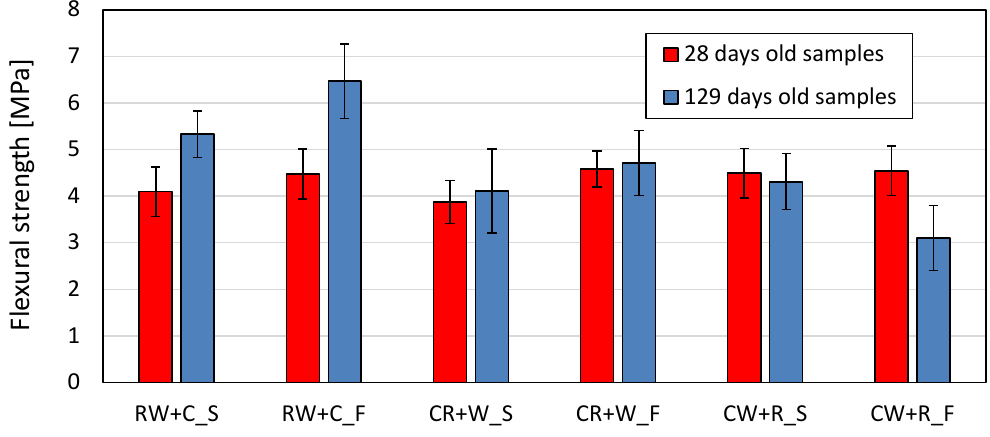
Figure 4. Flexural strength of the samples (with standard